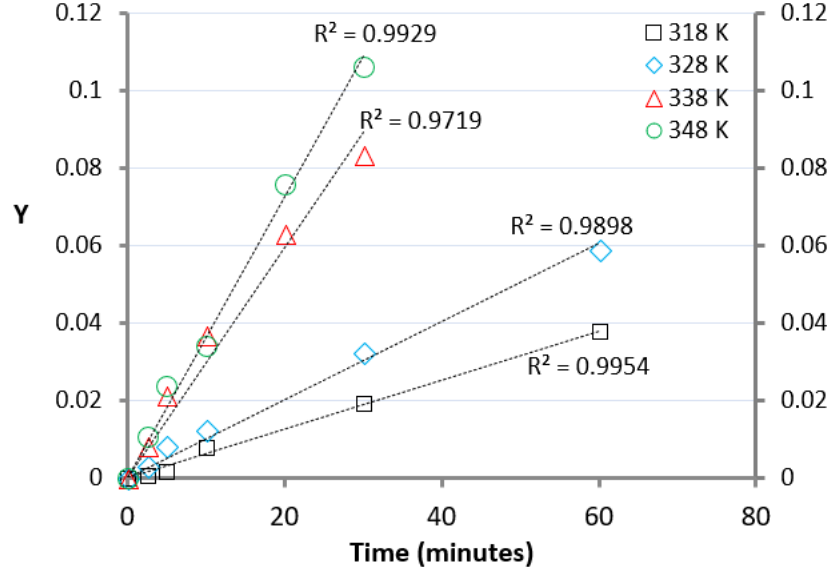
Figure 2. Evaluation of the kinetic constant at different temperatures (from 318 to 348 K) for the forward reaction ( k’ ) for LA and ethanol.